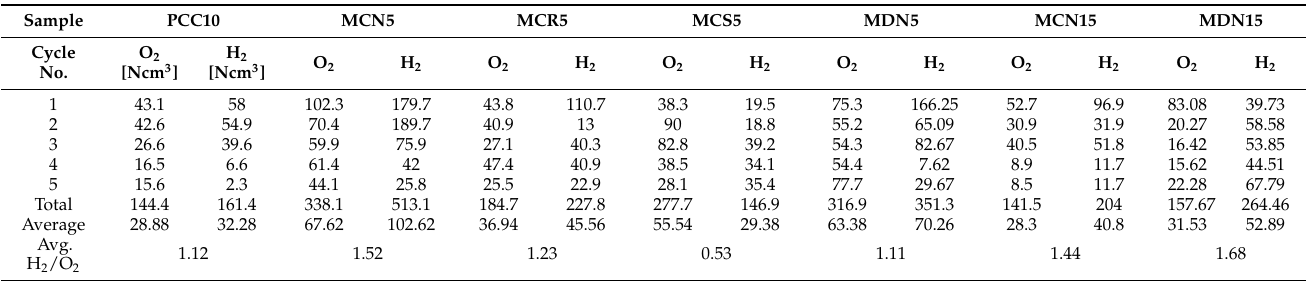
Table 3. Experimental result of five cyclic tests, total production amount, and average production amounts for oxygen and hydrogen.